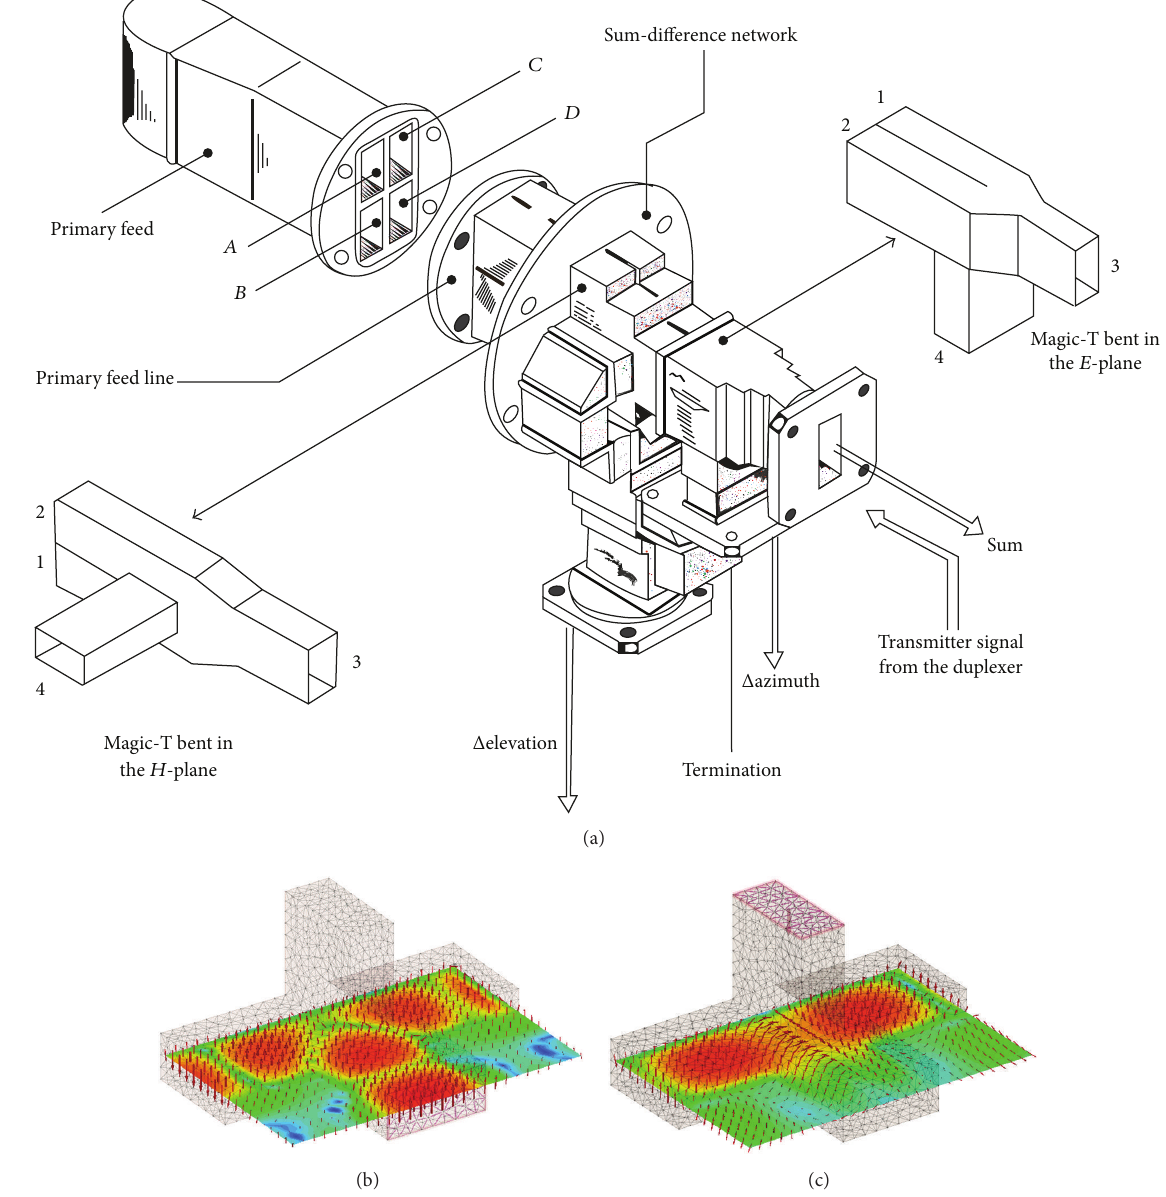
Figure 6: (a) Antenna feed. (b) E-field simulation for sum and (c) difference